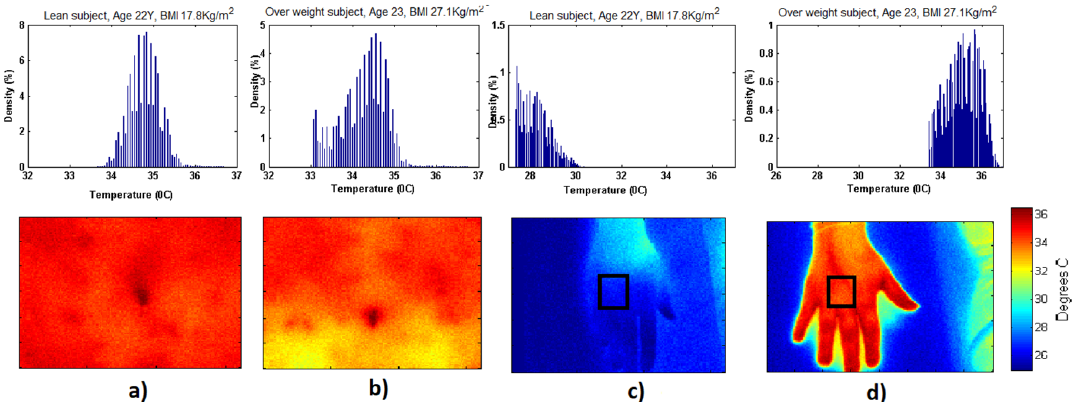
Figure 2. Thermal images of hand and abdomen of two subjects with matching age but different BMI, ( a ) lean subject abdomen: Gaussian-like thermal distribution, ( b ) overweight subject abdomen: non-Gaussian thermal distribution; ( c ) Lean subject hand: non-Gaussian thermal distribution, ( d ) Overweight subject hand: non-Gaussian thermal distribution.